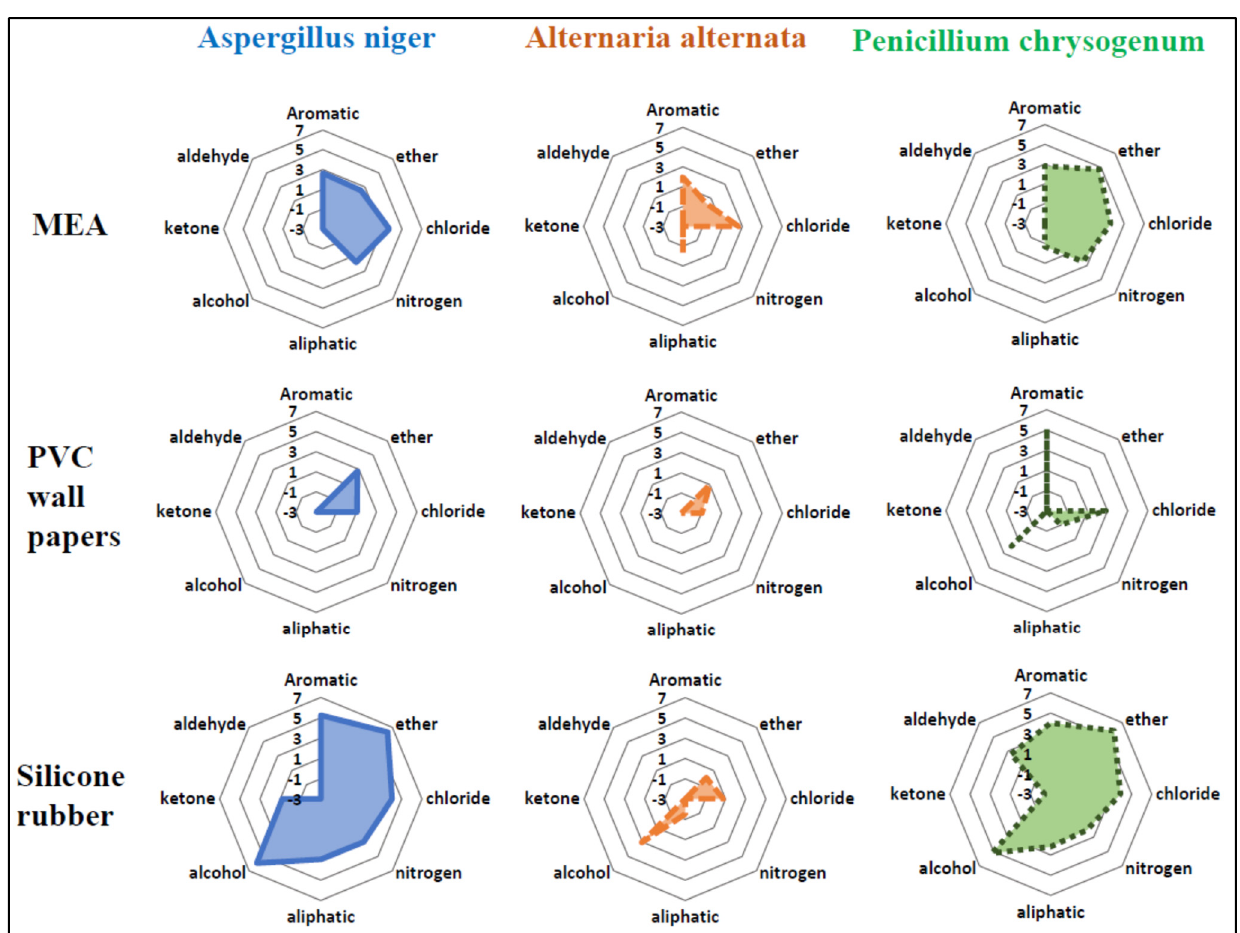
Figure 2. Emission patterns for eight groups of compounds with different growth media and fungi (three growth media by three fungi). The radar charts were presented on a natural logarithmic scale.